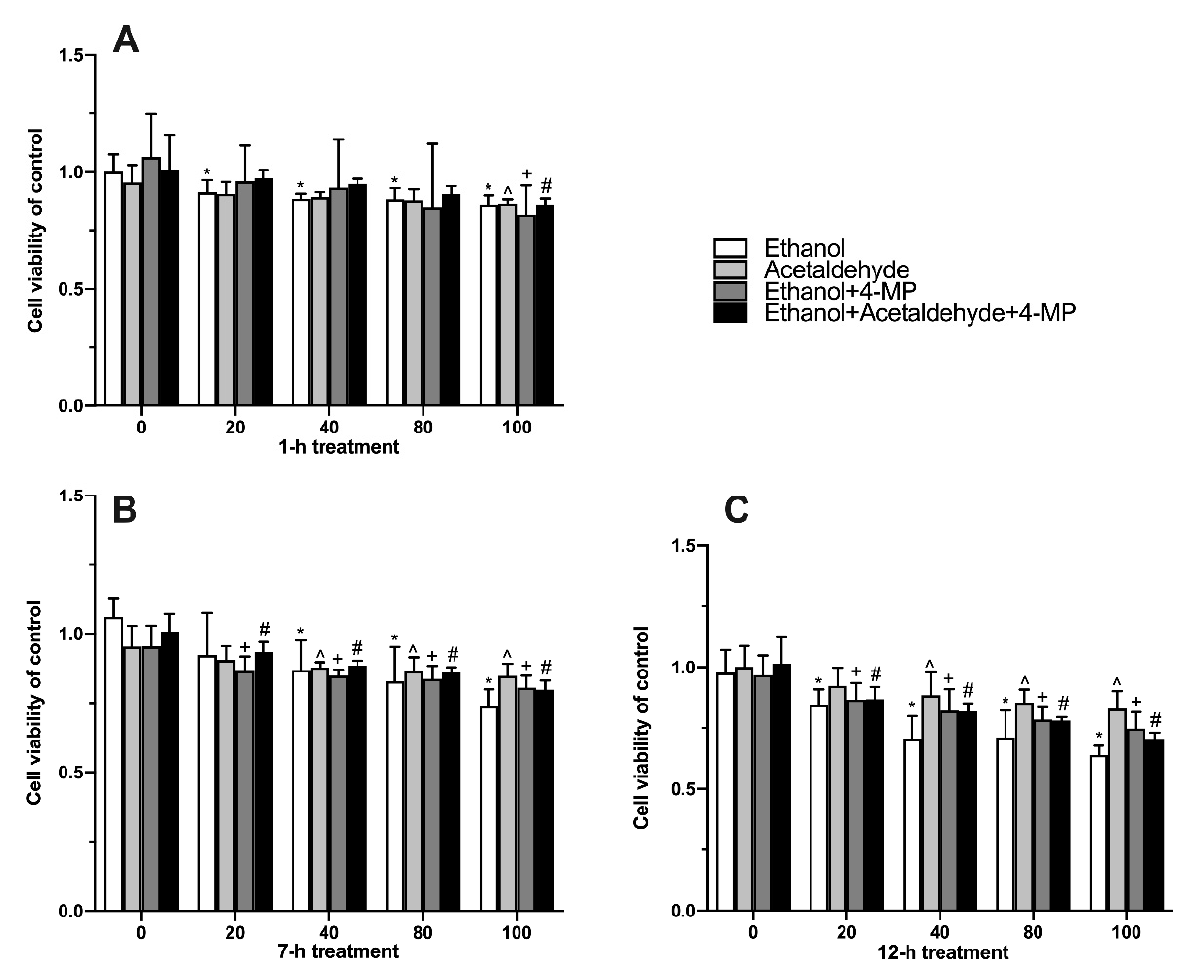
Figure 2. Effect of four different treatments on cell proliferation in L02 cell lines treated for 1 h ( A ), 7 h ( B ), and 12 h ( C ). Values represent the means ± SD (n ≥ 6). * p < 0.05 compared with 0 mM ethanol, ^ p < 0.05 compared with 0 µM acetaldehyde, + p < 0.05 compared with 0 mM ethanol + 500 µM 4-MP, # p < 0.05 compared with 0 mM ethanol + 0 µM acetaldehyde + 500 µM 4-MP.